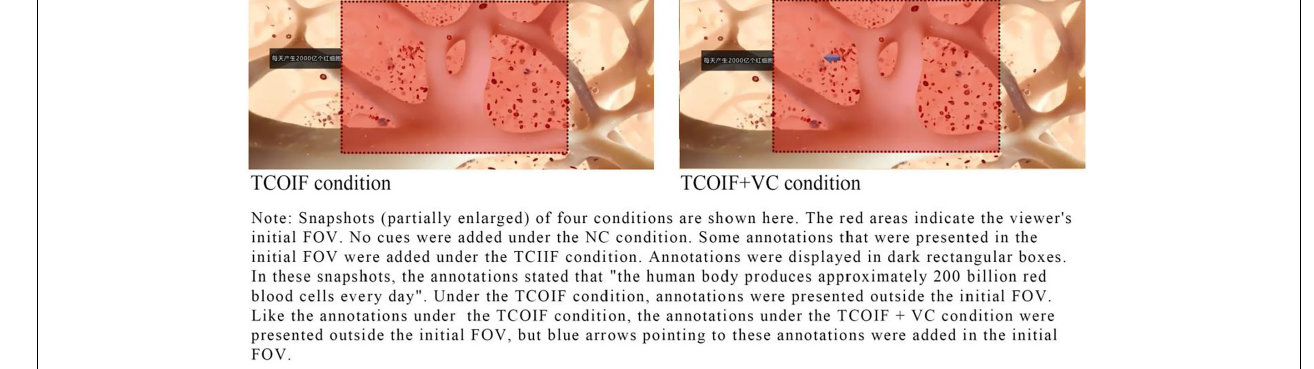
FIGURE 2 | Snapshots of the four